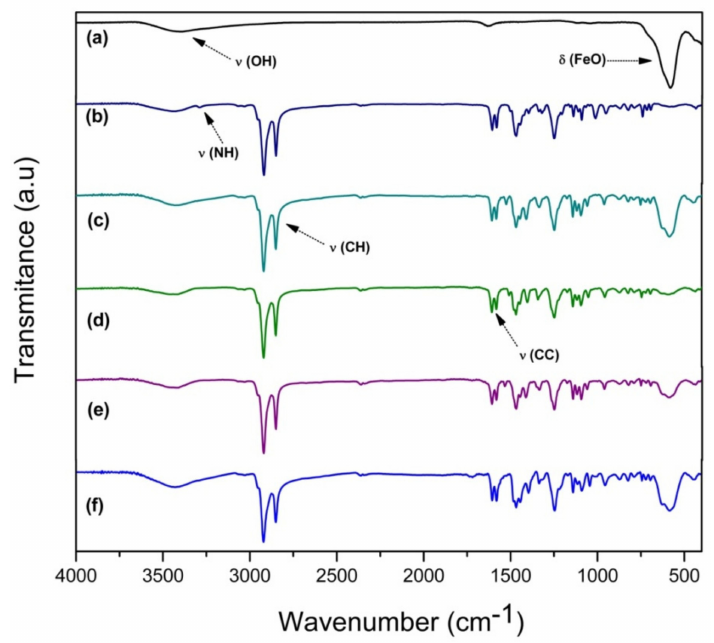
Figure 1. FT-IR analysis of ( a ) Fe 3 O 4 ; ( b ) Fe 3 O 4 @OA / Pc; ( c ) Fe 3 O 4 @OA / CoPc; ( d ) Fe 3 O 4 @OA / CuPc; ( e ) Fe 3 O 4 @OA / NiPc; and ( f ) Fe 3 O 4 @OA /